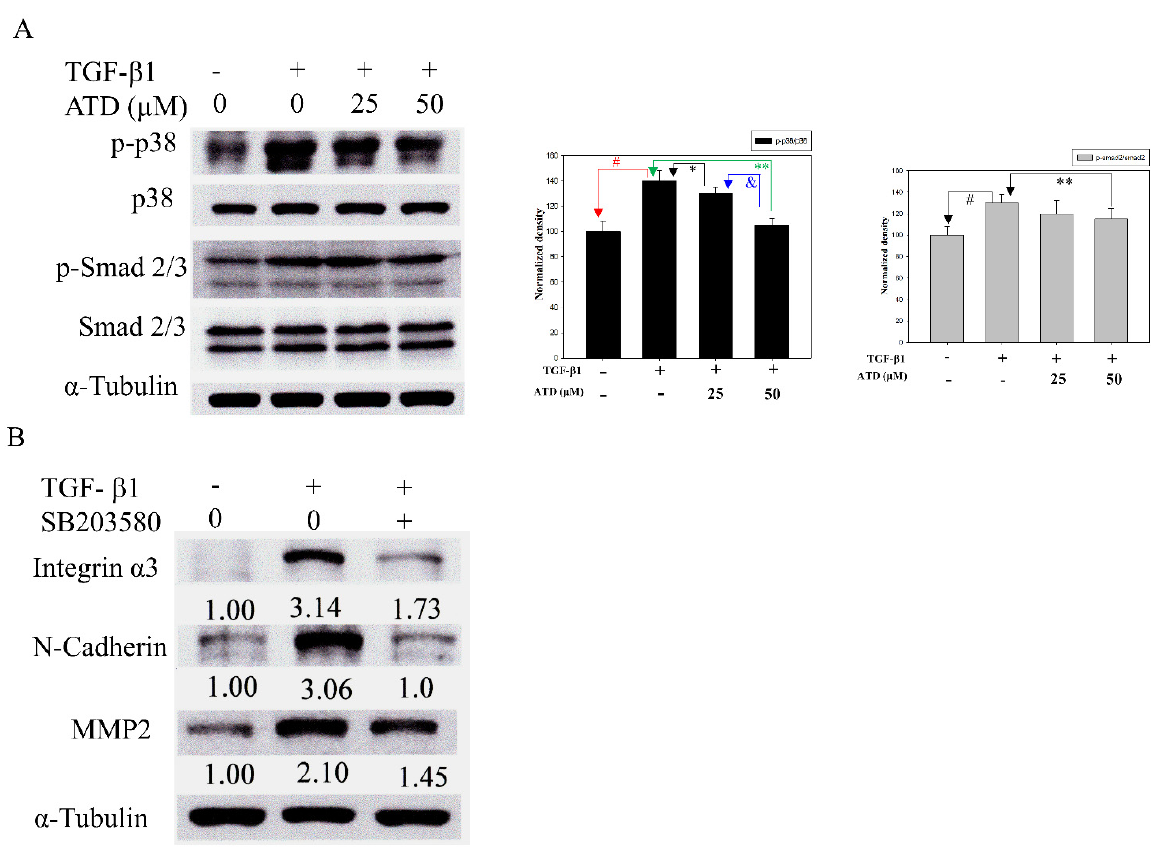
Figure 8. Effect of ATD on TGF- β 1-induced p38MAPK and Smad 2/3 pathway. ( A ) After treatment of TGF- β 1 and ATD as described in the text, the cell lysates were prepared and subjected to immunoblotting analysis using antibodies against p-p38MAPK, p-Smad 2/3, p38MAPK, Smad 2/3, and α -tubulin (loading control). The average densitometric value was shown as mean ± SD ( n = 3). #: TGF- β 1 vs. control, p < 0.05; *: TGF- β 1 vs. TGF- β 1+ 25 µ M ATD, p < 0.05; ** TGF- β 1 vs. TGF- β 1+ 50 µ M ATD, p < 0.01; &: TGF- β 1+ 25 µ M ATD vs. TGF- β 1+ 50 µ M ATD, p < 0.05. ( B ) Cells were pretreated with or without TGF- β 1 for 24 h, then co-treated with 5 μ M p38 MAPK inhibitor (SB203580) and TGF- β 1 for an additional 24 h. The cell lysates were subjected to immunoblotting analysis using antibodies against integrin- α 3, N-cadherin, MMP2, and α -tubulin (loading control). The relative image density was quantitated by a densitometer.